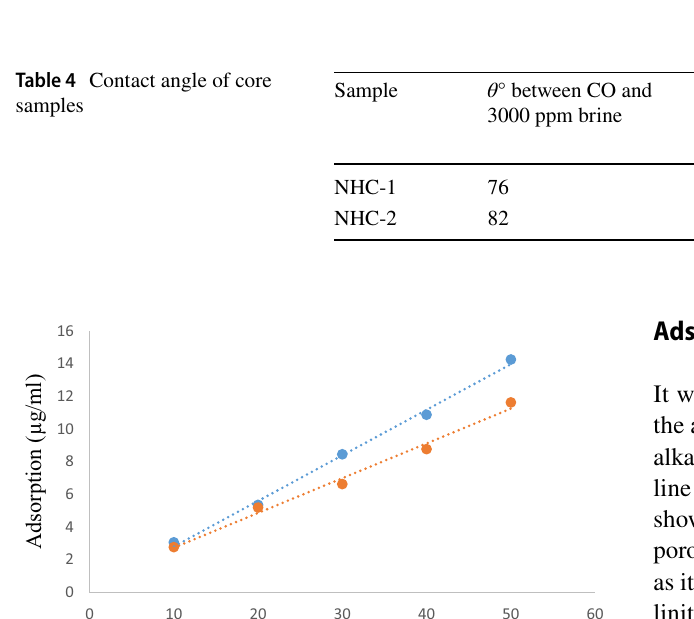
Table 3 Wettability from relative permeability of oil with respect to water, during the imbibition process